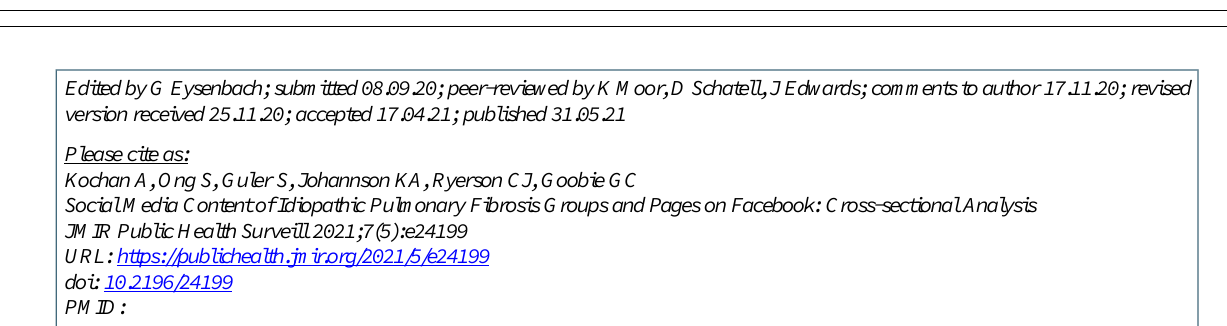
ILD: interstitial lung disease IPF: idiopathic pulmonary